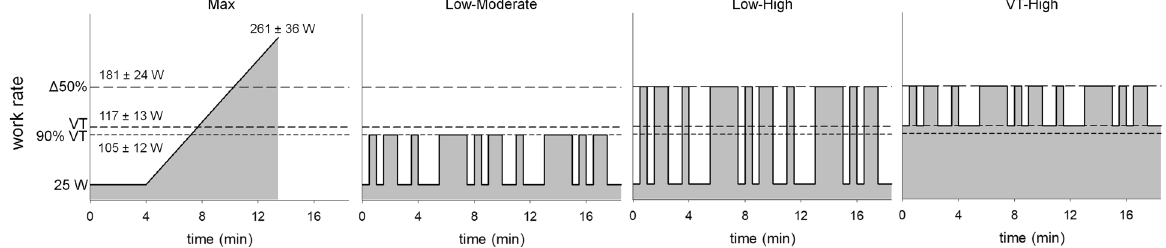
Fig. 6 Schematic showing the incremental ramp and three pseudorandom binary sequence (PRBS) cycling tests. PRBS protocols were designed using work rates at 90% ventilatory threshold (VT), VT, and the midpoint between VT and _ VO VT and _ VO determined from the ramp 2 peak